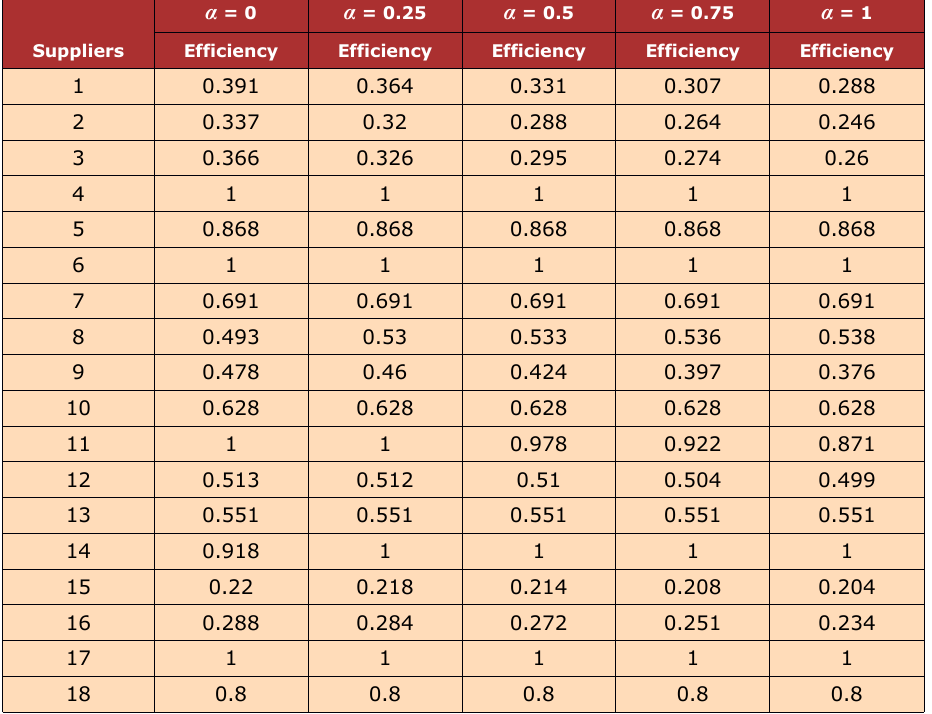
Table 6. Original matrix for different levels of